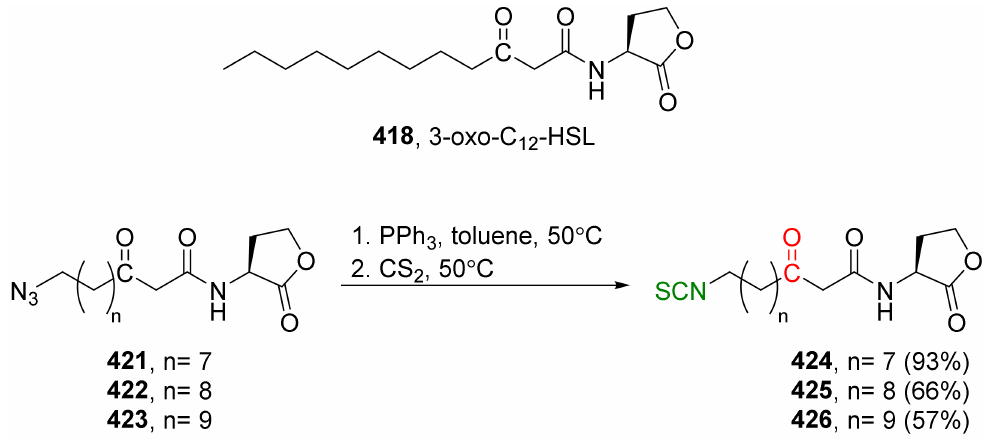
Figure 46. Synthesis of ITCs 424 – 426